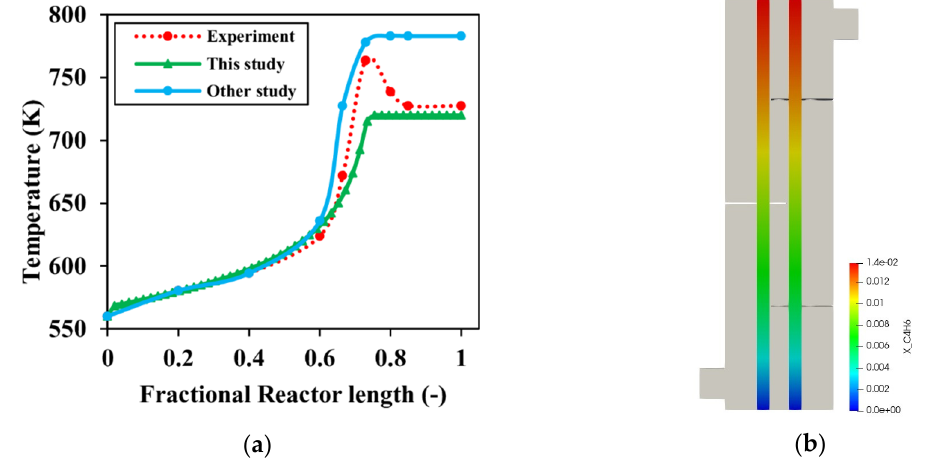
Figure 6. Validation of the CFD model under adiabatic conditions: ( a ) temperature comparison between CFD simulation, experimental data, and simulation reported by Sterrett et al. [18]; ( b ) concentration profiles of the CFD simulation.